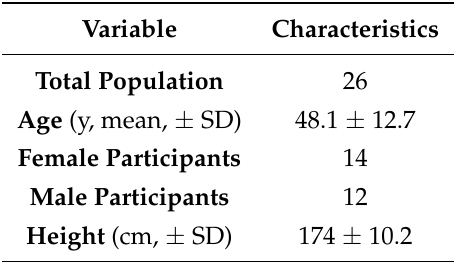
Table 1. Characteristics of the study population, including age, sex and height. For validation, two types of models were used: k-fold cross-validation and subject-wise cross-validation.